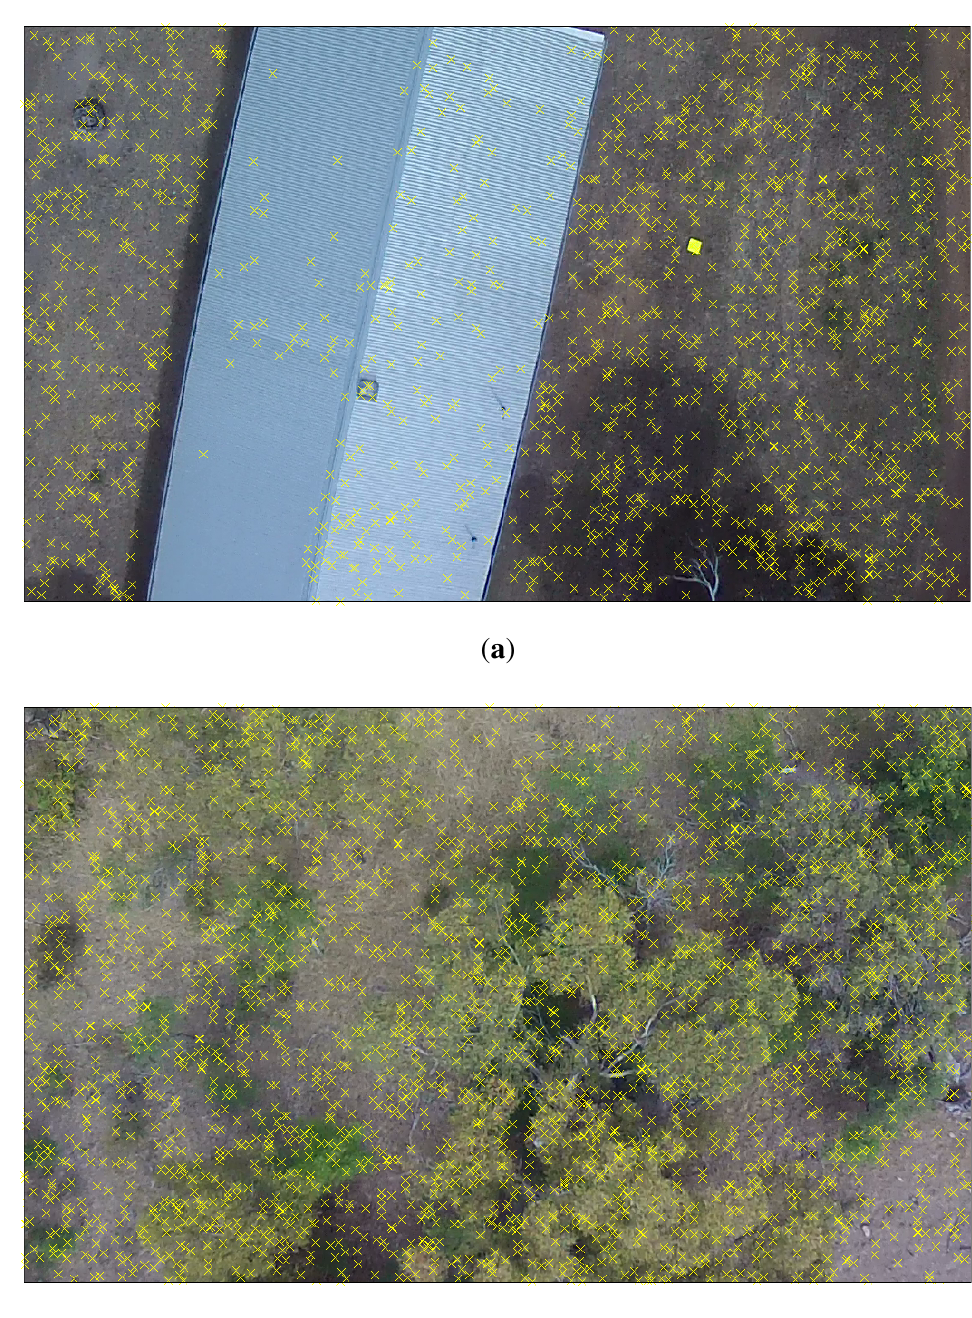
Figure 5. The detection of SIFT features (yellow crosses) within ( a ) a frame dominated by the building in the center of the study area, 1714 SIFT features were found and ( b ) a frame dominated by natural features including trees, 2959 features were